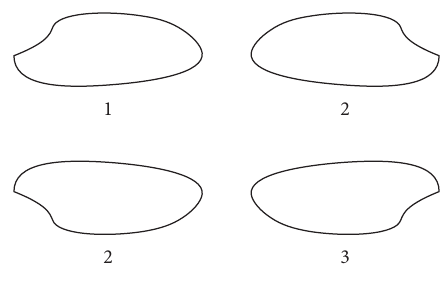
Figure 11: Image of the germ position.